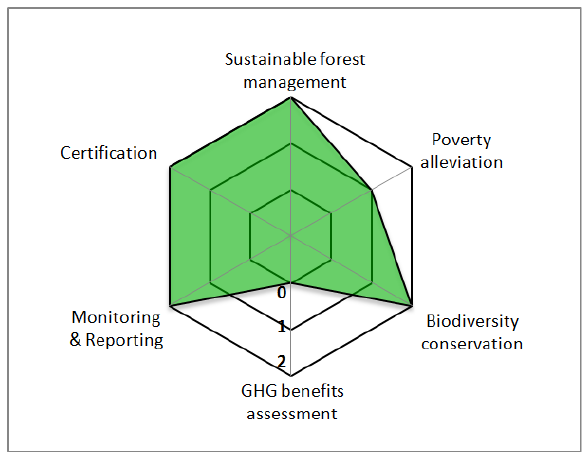
Figure 1. Evaluation of CCBA REDD+